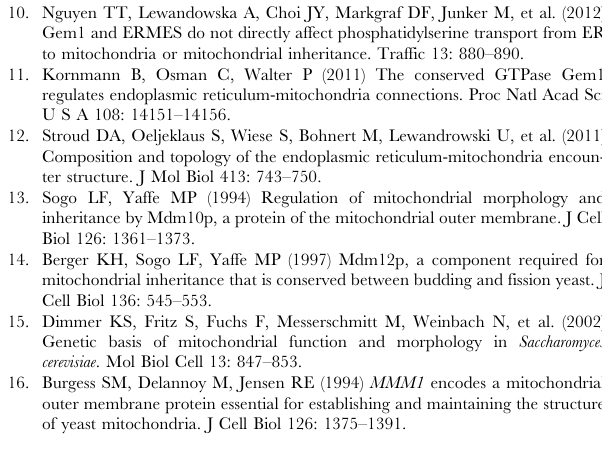
Figure S1 Mmm1-HA rescues D mmm1 phenotypes. (PDF) Figure S2 Measurement of mitochondrial diameter in mutant strains. (PDF) Figure S3 Alignment of fungal Mmm1 proteins. (PDF) Figure S4 Cysteine mutants have normal TOM complex and Tim8/13 levels. (PDF) Figure S5 Alkali extraction of mitochondria from Mmm1 mutant A116-124.